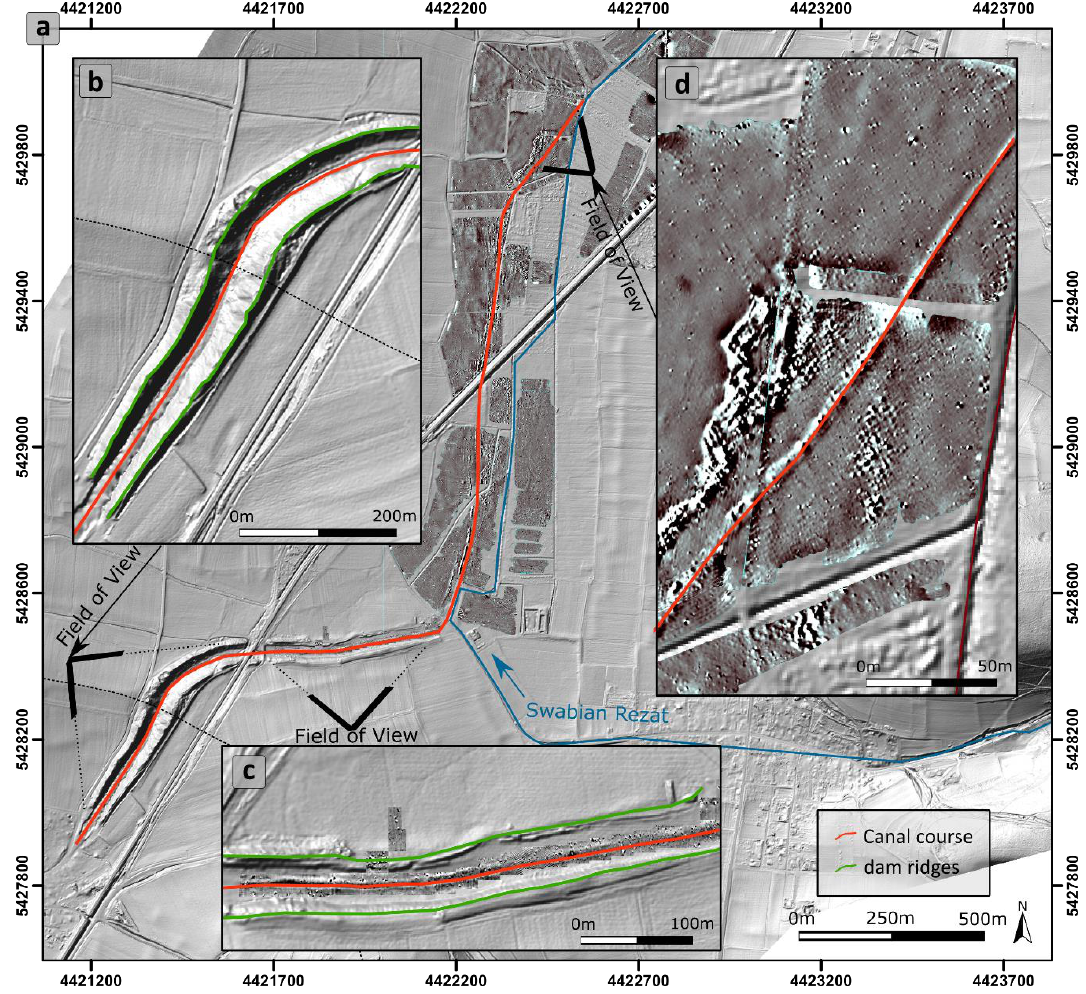
Figure 5. Localisation of the Fossa Carolina course. ( a ) Total study area, magnetic maps and Digital Terrain Model (DTM) data, ( b ) Central Section with canal course and dam ridges, ( c ) West-East Section with canal course, dam ridges and Fluxgate magnetic map, ( d ) North-Eastern Section with canal course and SQUID (Superconducting Quantum Interference Device) magnetic map, Greyscale: ±10 nT/m.